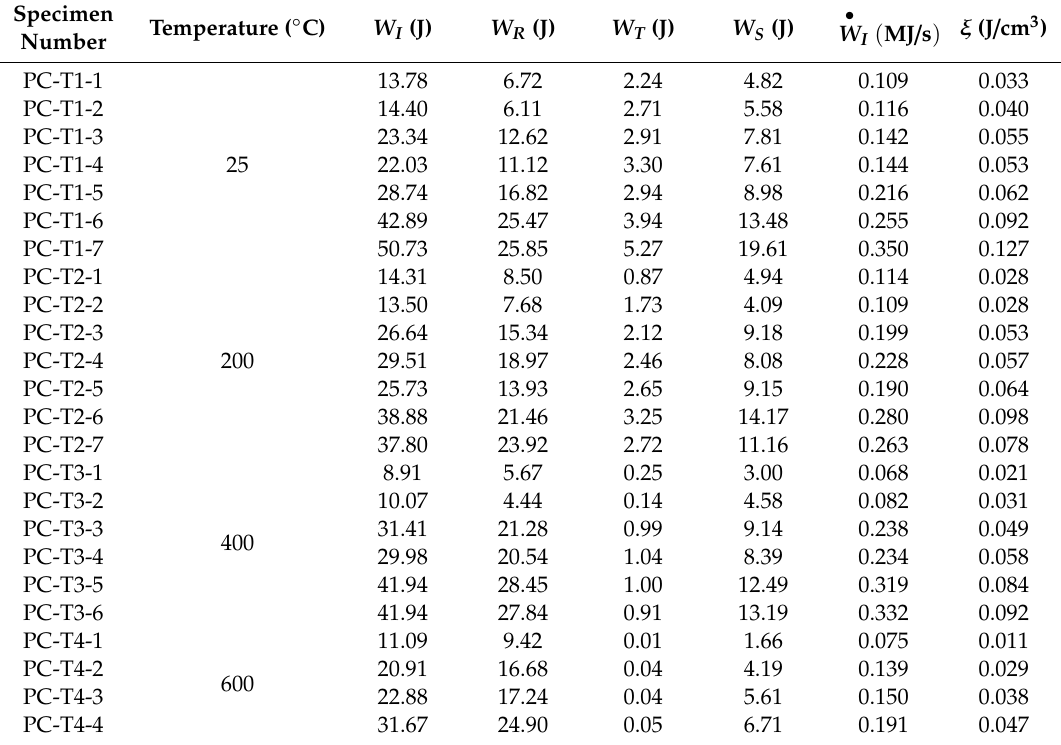
Table 4. Energy results of the SHPB test of concrete at di ff erent temperatures.